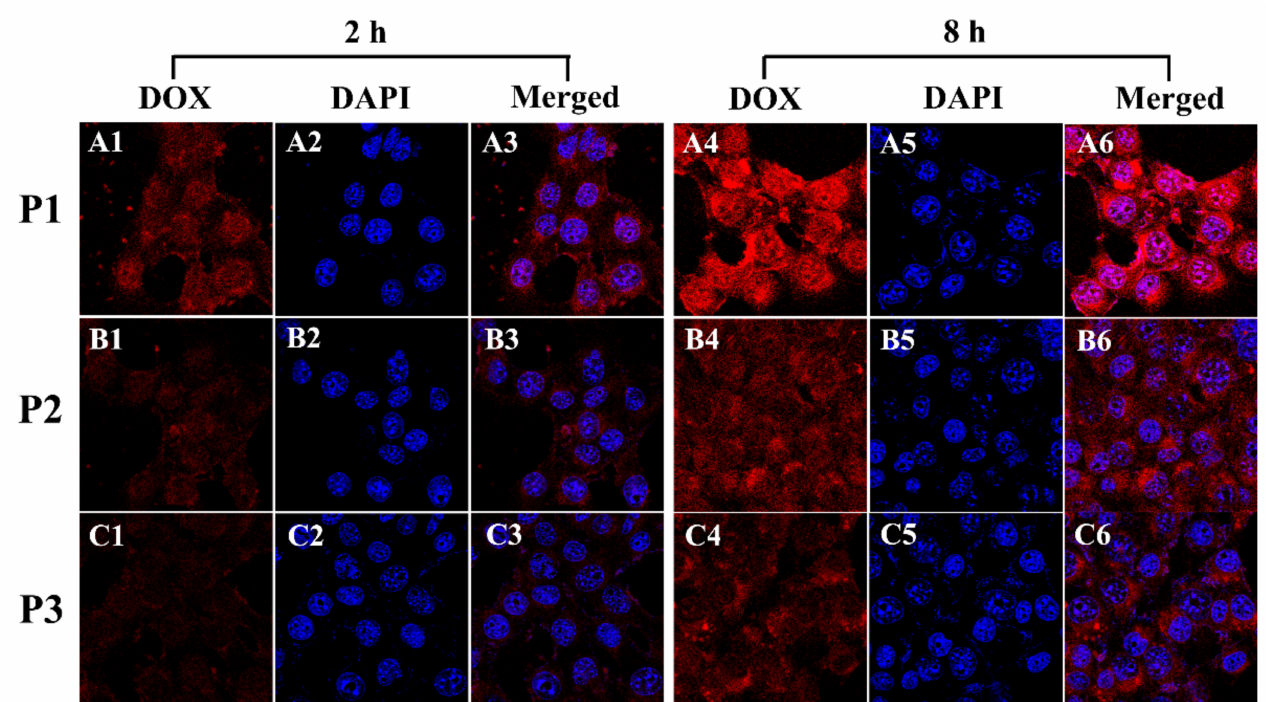
Figure 7. CLSM images of 4T1 cells incubated with P1 ( A1 – A6 ), P2 ( B1 – B6 ), P3 ( C1 – C6 ) for 2 h and 8 h, respectively.